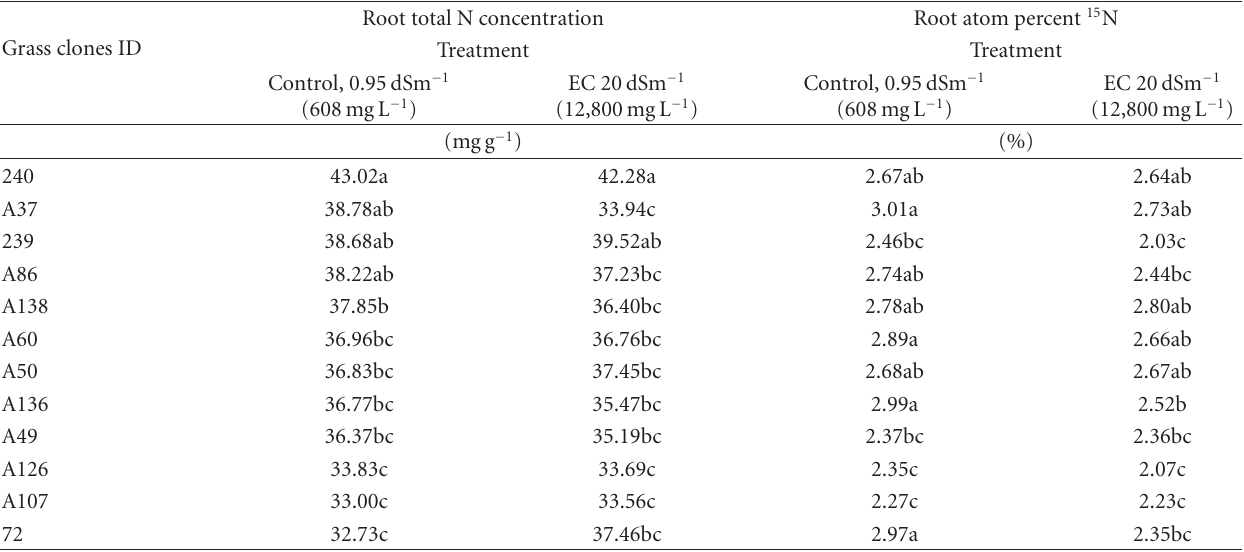
Table 6: Total nitrogen concentration (mgg − 1 ) and atom percent 15 N of various clones of saltgrass root tissues under the control and salt (NaCl) stress